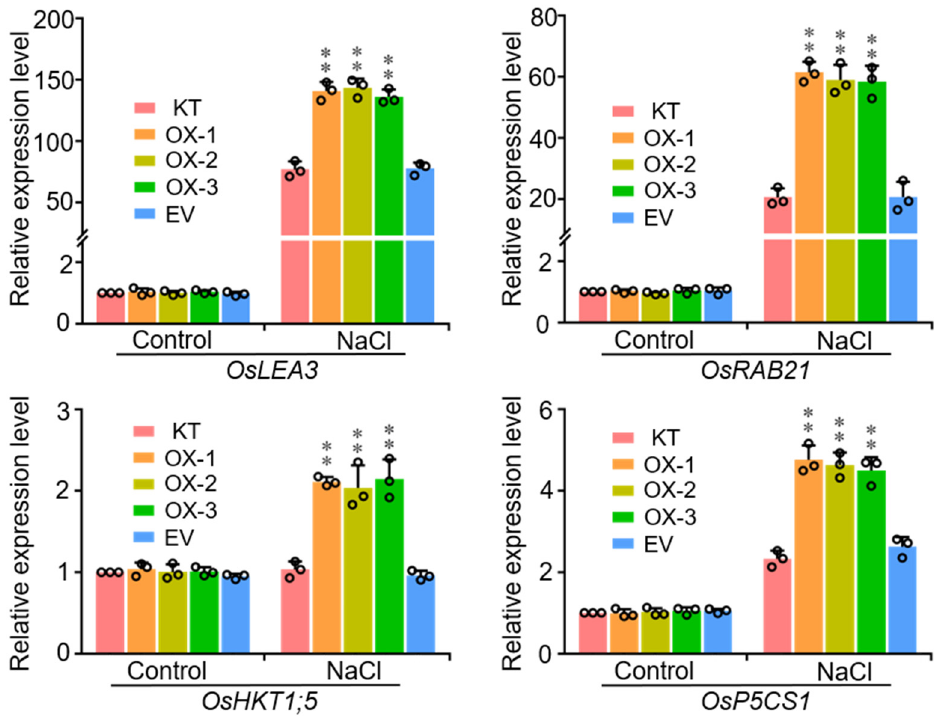
Figure 4. Expression levels of stress responsive genes. KT, OX-1, OX-2, OX-3, and EV plants treated with 100 mM NaCl for 1 h were collected for RNA extraction. Total RNA (2 µ g) was used for cDNA synthesis by reverse transcription-polymerase chain reaction (RT-PCR). Ubiquitin was used as the internal control. Data represent means ± SD ( n = 3). ** p < 0.01 (Student’s t ‐ test).